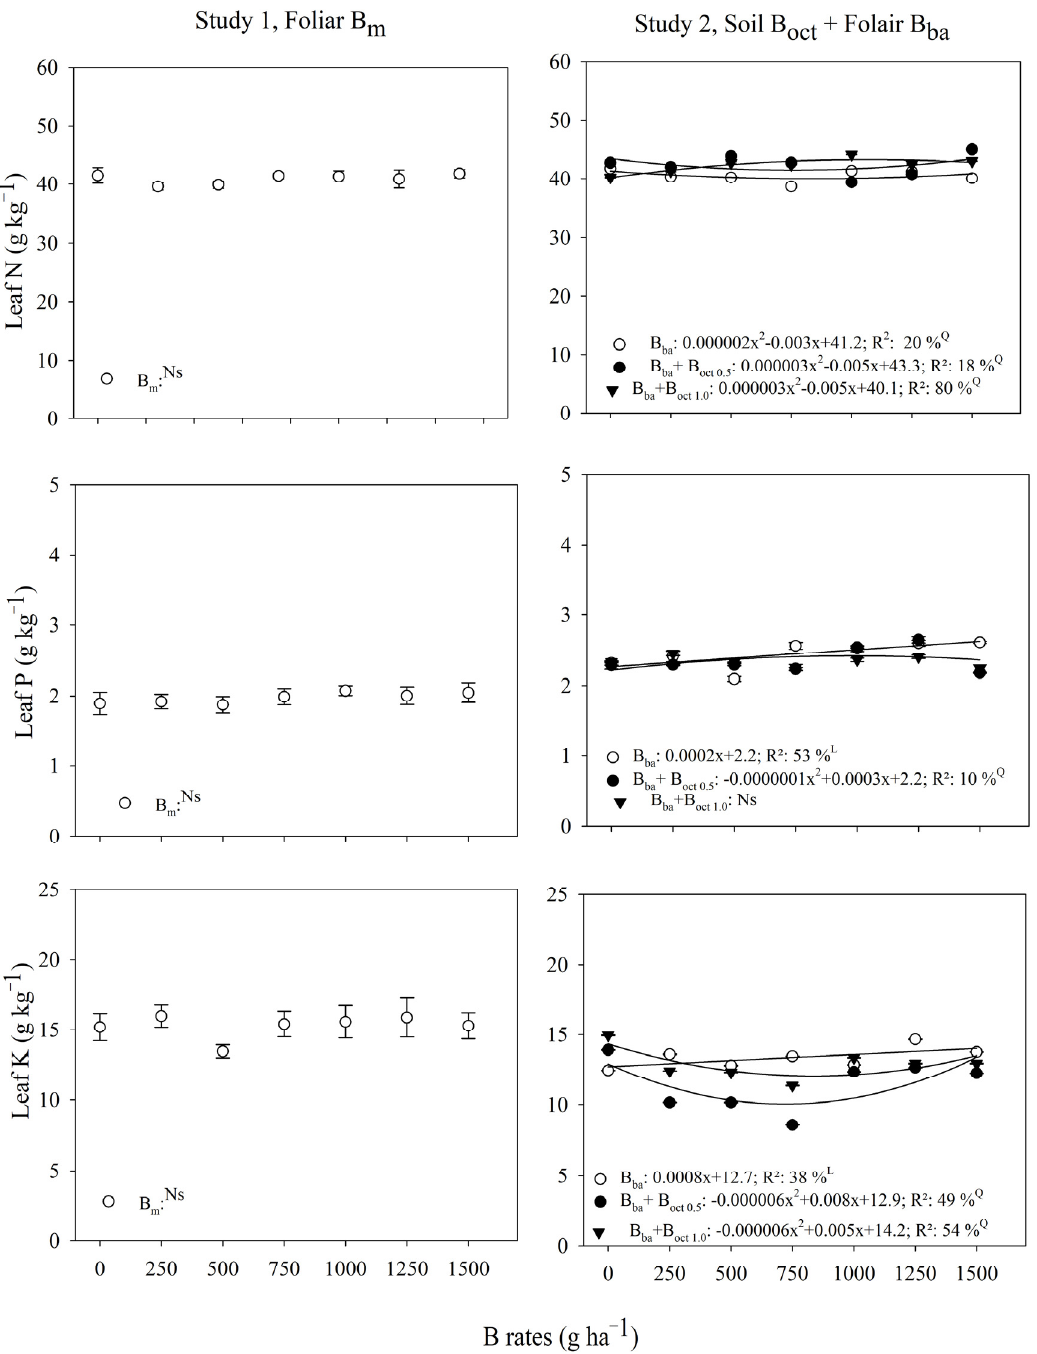
Figure 5. Leaf nitrogen (mg kg − 1 ), leaf phosphorus (g kg − 1 ), and leaf potassium (g kg − 1 ) in Study 1 with foliar application of B (Bm, monoethanolamine) using six B rates (250, 500, 750, 1000, 1250 and 1500 g ha − 1 ), and in Study 2 with B application in soil using sodium octaborate (Boct) with two rates (Boct0.5: 0.5 kg ha − 1 ; and Boct1.0: 1.0 kg ha − 1 ), and the foliar B application using boric acid (Bba) with six rates (250, 500, 750, 1000, 1250, and 1500 g ha − 1 ). L and Q: linear and quadratic models, respectively. Averages presented with error variation. Boct0.5 = sodium octaborate at 0.5 kg ha − 1 ; Boct1.0 = sodium octaborate at 1.0 kg ha − 1